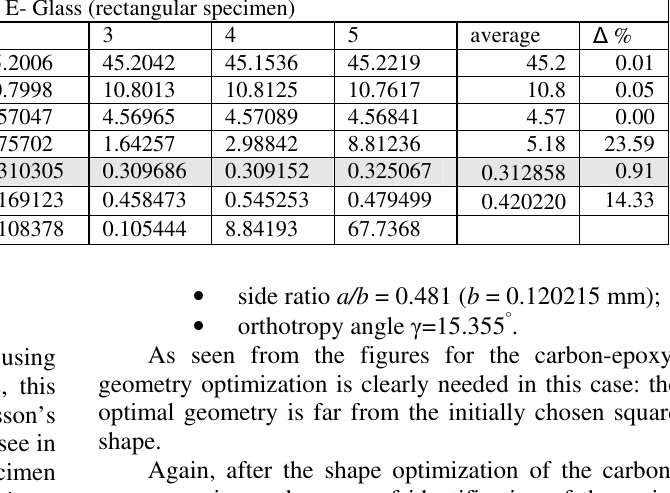
E- Glass (rectangular specimen)